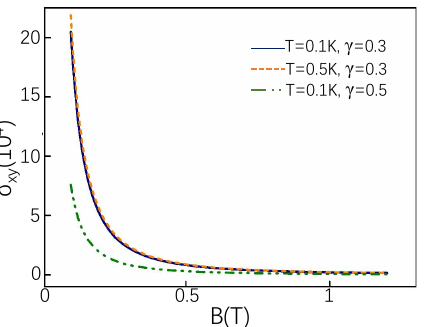
Figure 6. Hall conductivity(in units of e 2 ) as function of magnetic field at different temperatures ( 2 π ) 2 and tilt terms. The parameters µ = 20.2 eV for γ = 0.5 and µ = 13.7 eV for γ = 0.3. Similar to the above, we take e = 1 and ¯ h =